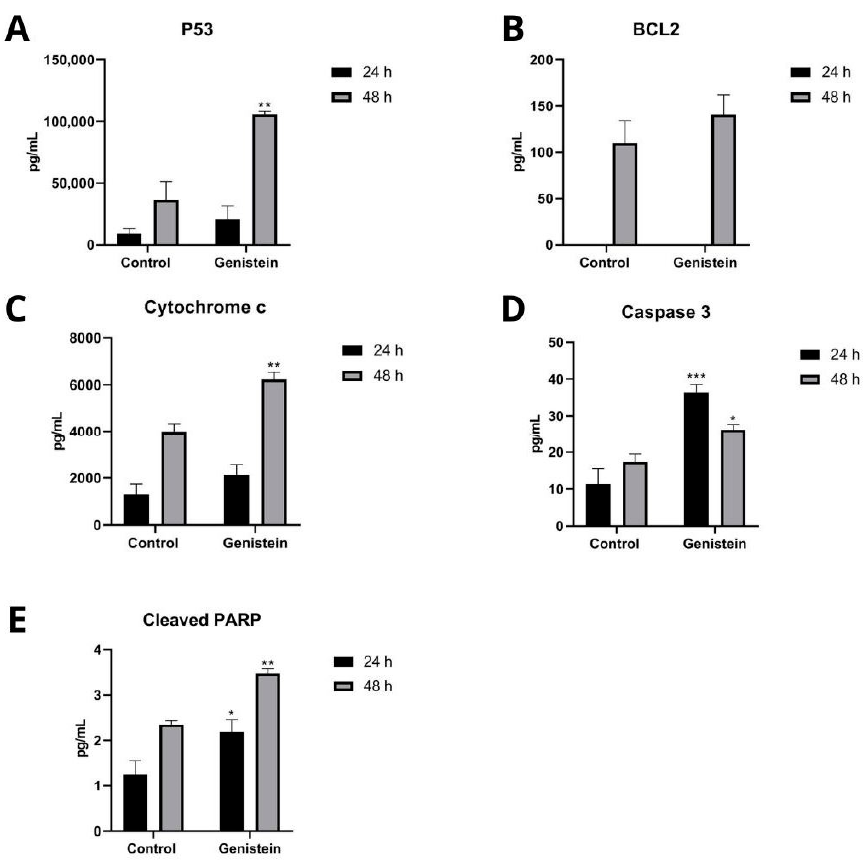
Figure 9. Effect of genistein on intracellular proteins that participate in the apoptosis process in SW620 cell line. Levels of each protein after treatment with genistein in two periods of time (24 h and 48 h) compared to the control. ( A ) p53. ( B ) BCL2. ( C ) Cytochrome c. ( D ) Caspase 3. ( E ) Cleaved PARP. p < 0.05 *; p < 0.01 **; and p < 0.001